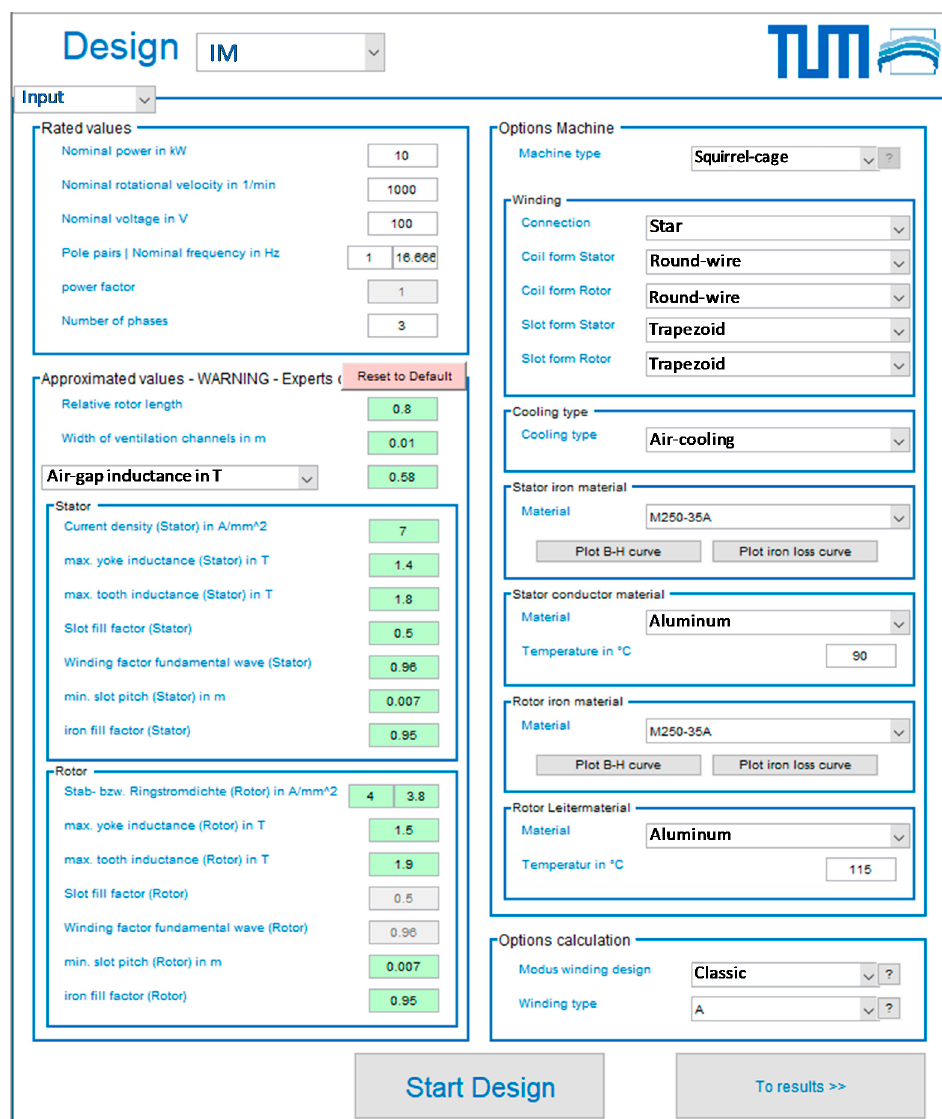
Figure 5. Input parameters for the machine design process.